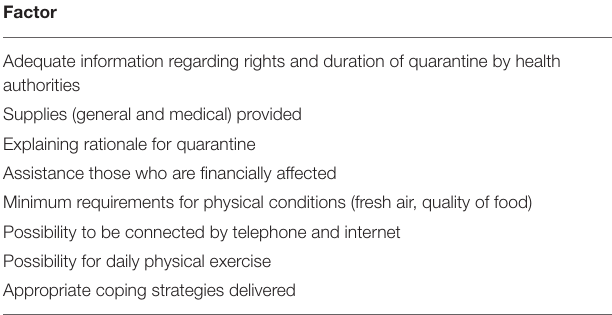
TABLE 1 | Proposed factors to minimize adverse effects of quarantine with flight crews.